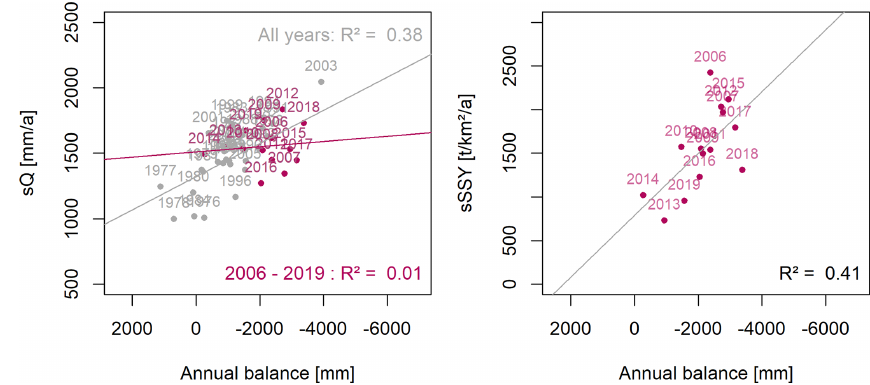
Figure 6. Correlation of annual specific discharge and annual specific suspended sediment yields at the gauge in Vent with the sum of annual mass balances of the two largest glaciers within the Vent catchment (in millimeters), Vernagtferner and Hintereisferner (World Glacier Monitoring Service, 2021), corresponding to the respective glacier areas. The grey points, line and R 2 in the left panel refer to the entire available sQ and mass balance time series starting in 1976.